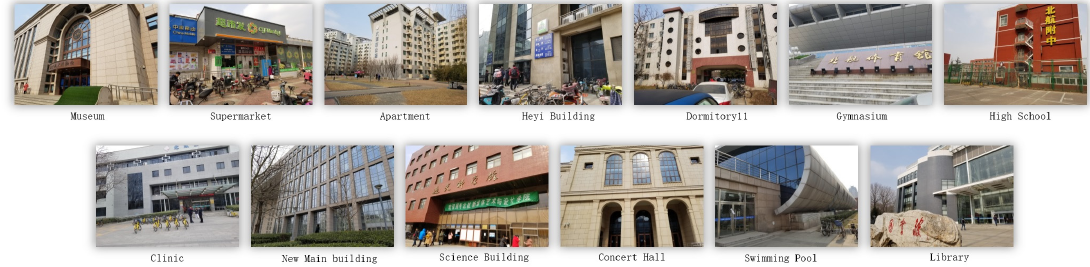
Figure 12. The high resolution BuaaFPV dataset. A total of 13 typical scenes were chosen from BUAA: